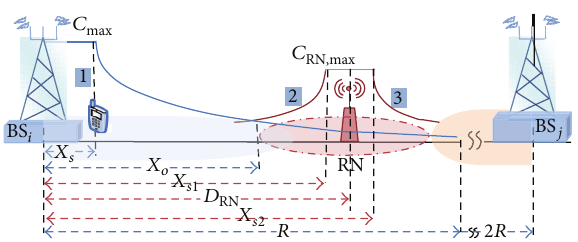
Figure 2: Scheme of proposed node